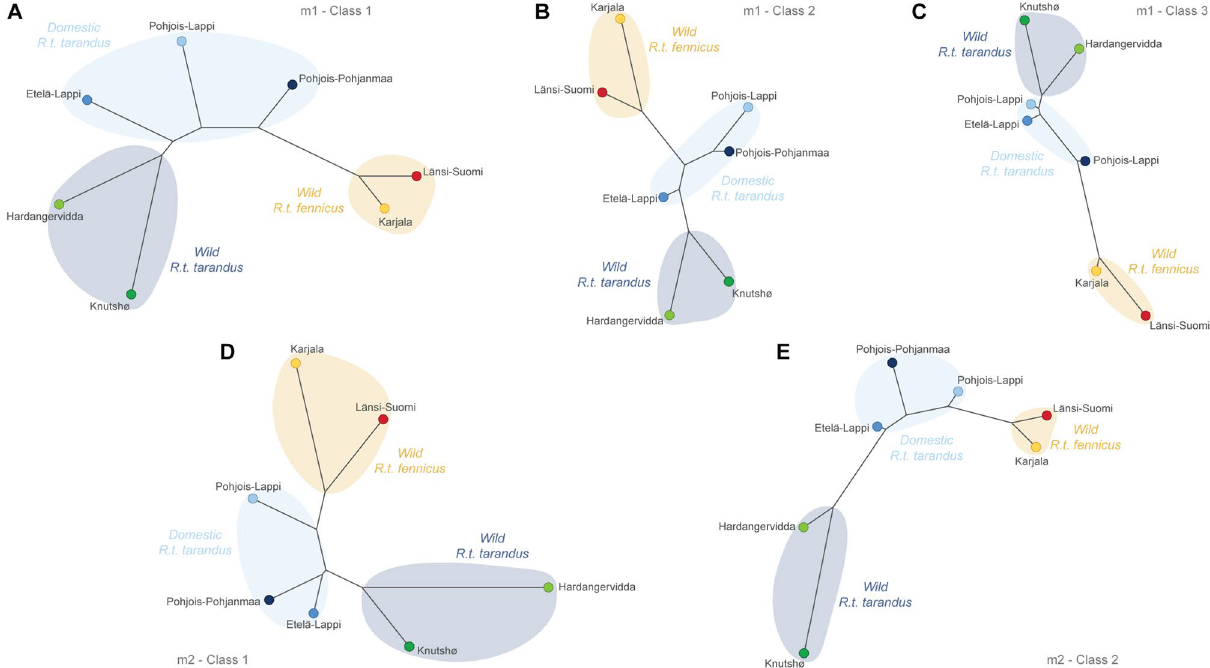
Figure 4. Neighbour-joining tree using Mahalanobis distances based on molar shape data from modern Fennoscandian populations for m1-Class1 ( A ), m1-Class2 ( B ), m1-Class3 ( C ), m2-Class1 ( D ) and m2-Class2 ( E